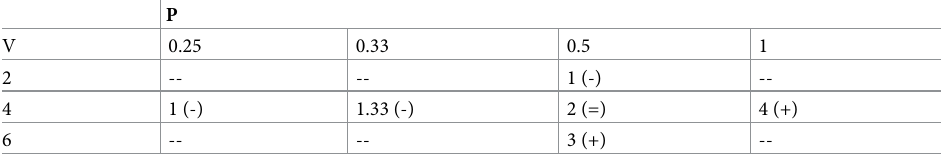
Table 1. Expected values (EV) of the risky option across the different conditions of probability to win (P) and of risky reward value (V) in Experiment 1. The safe option was always set at EV = 2. P V 0.25 0.33 0.5 1 2 -- -- 1 (-) -- 4 1 (-) 1.33 (-) 2 (=) 4 (+) 6 -- -- 3 (+)